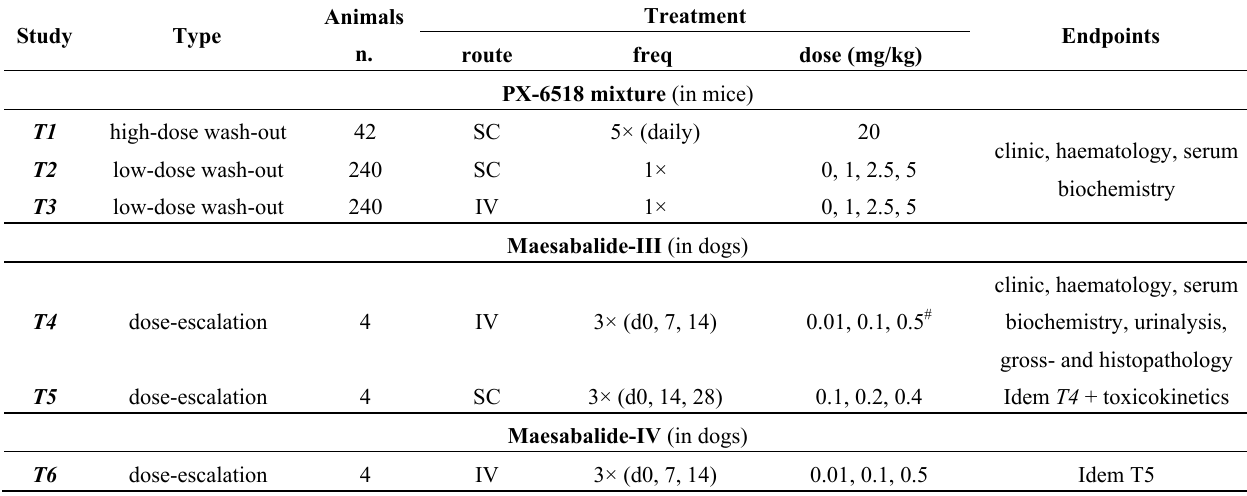
Table 1. Overview of in vivo toxicology